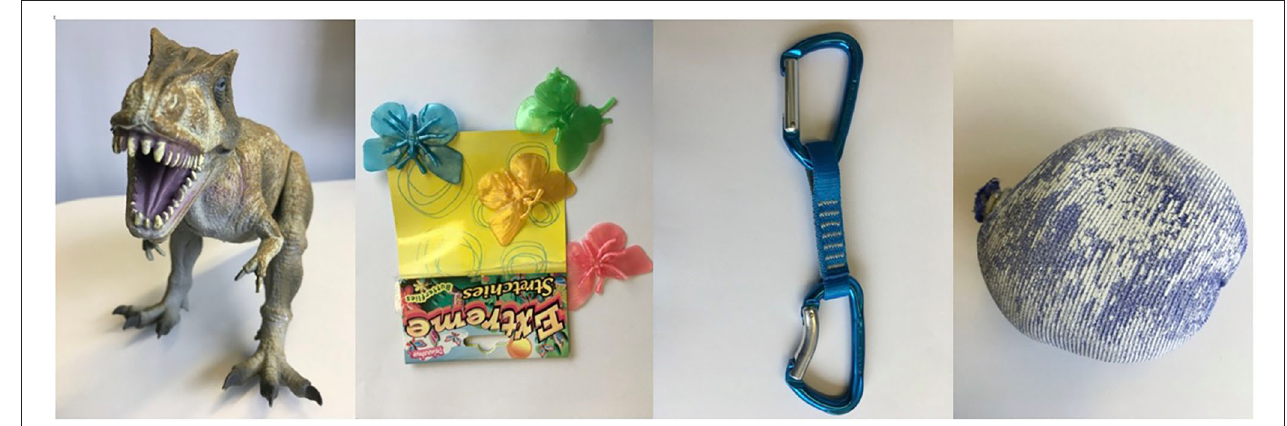
FIGURE 3 | “Touch” objects used as sensory props in interviews: plastic dinosaur, rubber butterfly, climbing clip and chalk